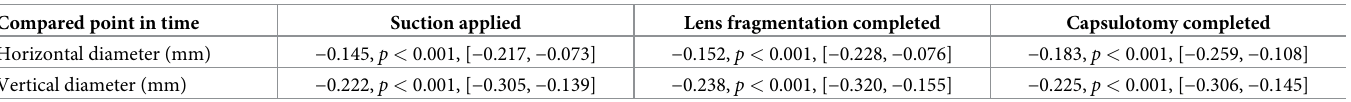
Table 3. Statistical analyses of change in pupil diameter within laser application steps as compared with preoperatively (paired t -test; mean change, p value [95% confidence interval]). A negative difference indicates increase in size as compared with the preoperative size. Compared point in